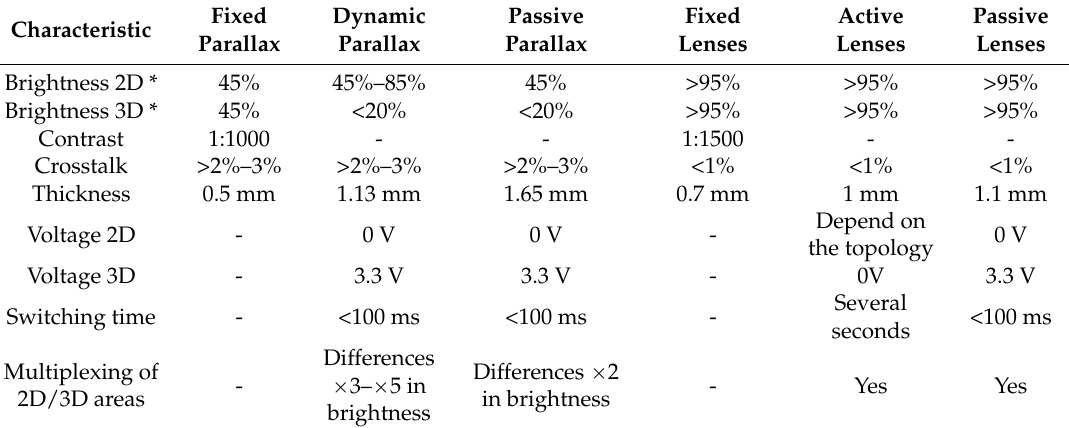
Table 2. Comparison between different autostereoscopic